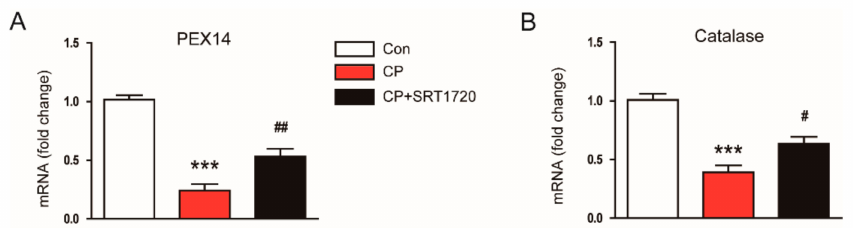
Figure 7. E ff ects of SRT1720 on markers of peroxisome number and function in mice treated with cisplatin. Real-time RT-PCR analysis of PEX14 ( A ) and catalase ( B ) in kidneys. *** p < 0.001 vs. Con. # p < 0.05 and ## p < 0.01 vs.